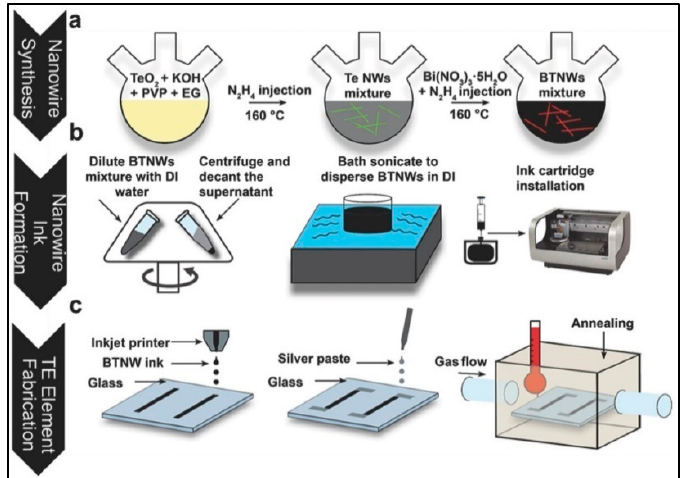
Figure 7. Schematic diagram of Bi2Te3 nanowire large-scale and low-cost synthesis based on inkjet printing: ( a ) Chemical batch processing, ( b ) Nanowire ink formation, and ( c ) Inkjet printing of the Bi2Te3 nanowires ink and post-annealing process. Reproduced with permission from [20]. Copyright Wiley Online Library, 2017.